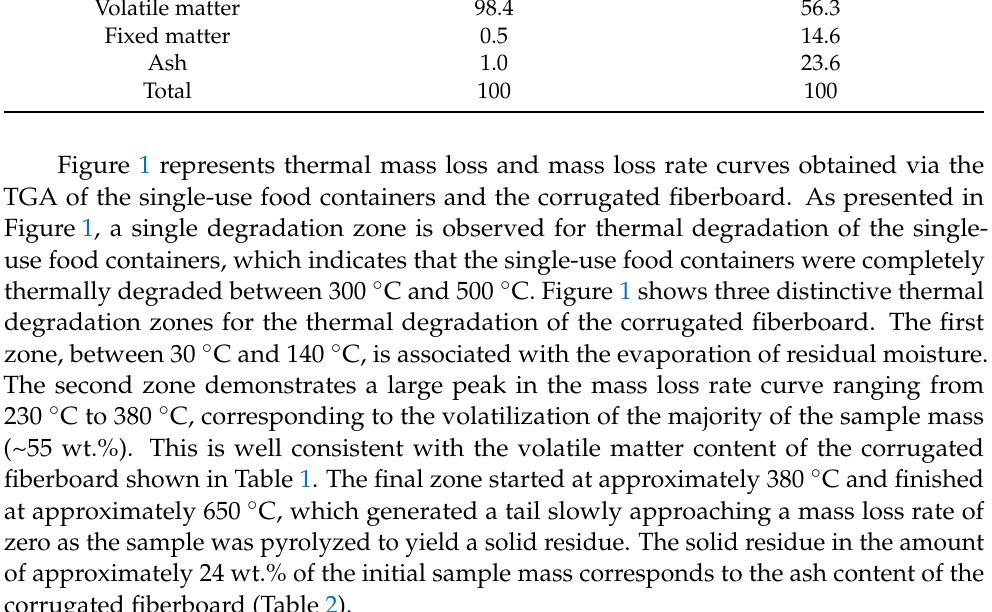
fiberboard shown in Table 1. The final zone started at approximately 380 ◦ C and finished zero as the sample was pyrolyzed to yield a solid residue. The solid residue in the amount of approximately 24 wt.% of the initial sample mass corresponds to the ash content of the corrugated fiberboard (Table 2).